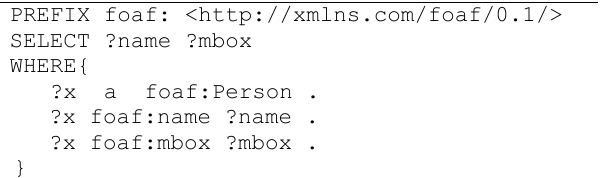
Figure 3. Example of